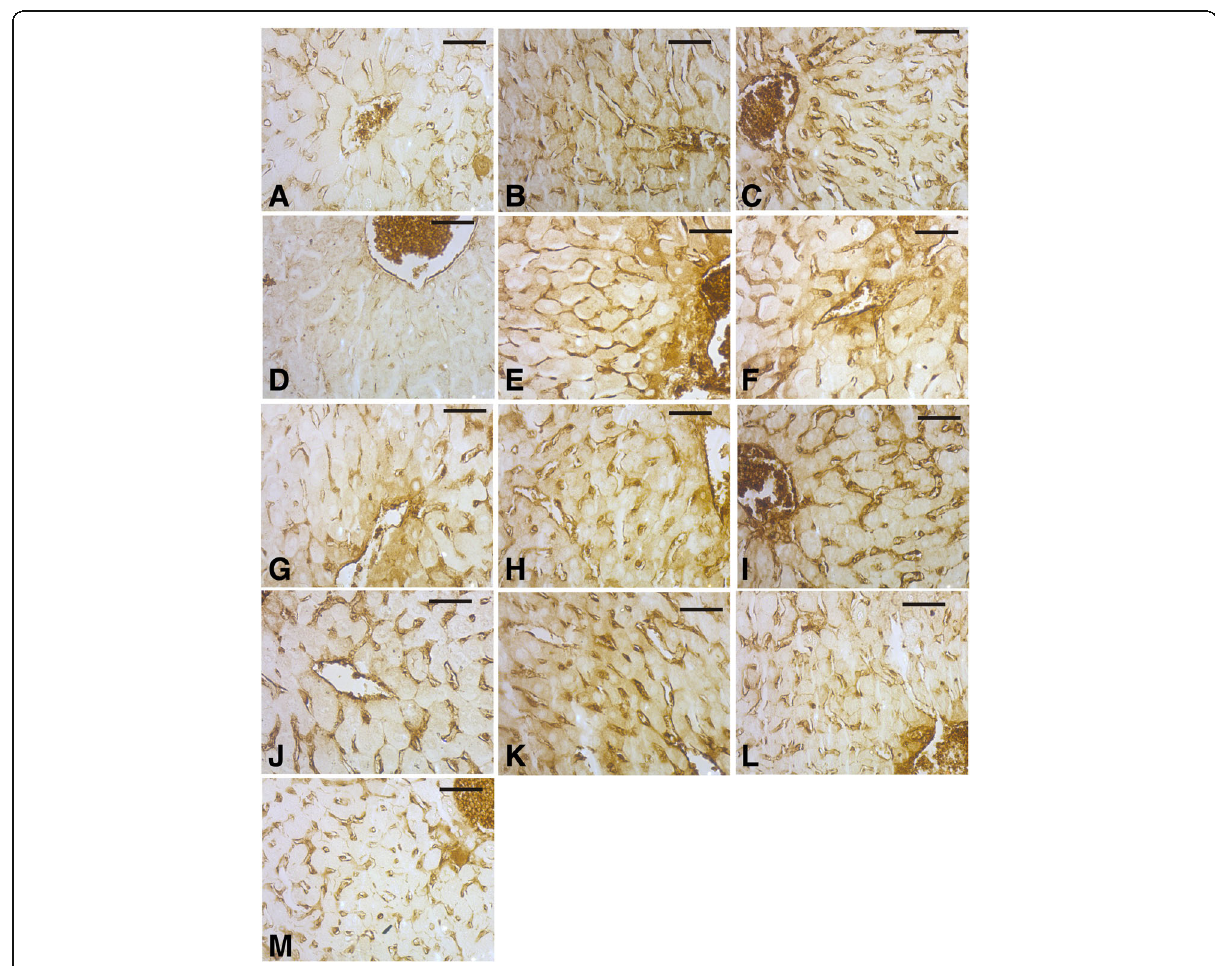
Fig. 3 Photomicrographs of immunohistochemistry of cytochrome C in liver sections of the control group ( a ). Acrylamide-administrated groups showed decrease in the expression at 60 days ( d ) in contrast to the elevated expression at 30 and 45 days ( b , c ). Chips feeding groups at 30, 45, and 60 days ( e – g ) showed elevated expression. BV-treated group ( h ) at 60 days showed higher cytochrome C expression compared to the control. BPF-treated group ( i ) showing an increase of cytochrome C expression. Acrylamide-administrated group treated with either BV ( j ) or BPF ( k ) showing improving downregulated expression of cytochrome C compared to acrylamide administration at 60 days. Chips feeding group treated with either BV ( l ) or BPF ( m ) showing the normal expression that was mostly similar to the control. Immunostaining of cytochrome C scale bar 10 μ